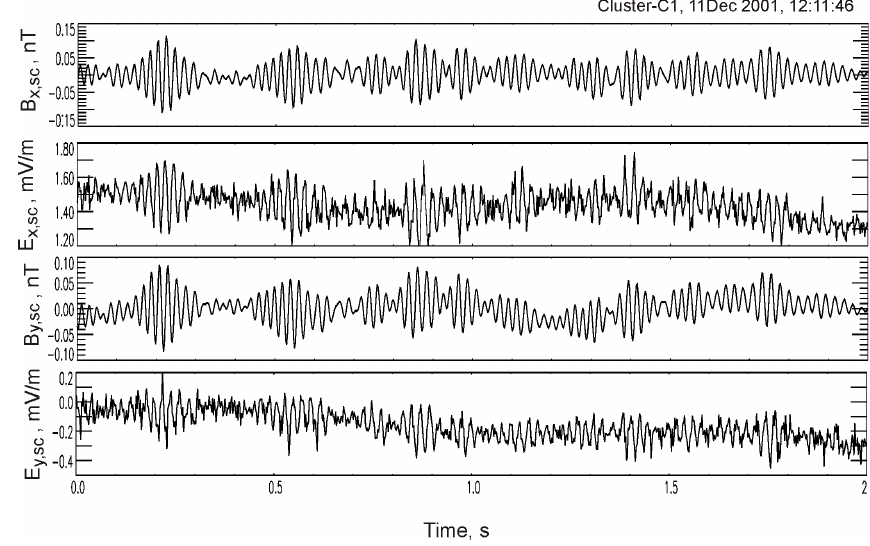
Fig. 8. The magnetic and electric field variations in the whistler wave packets.